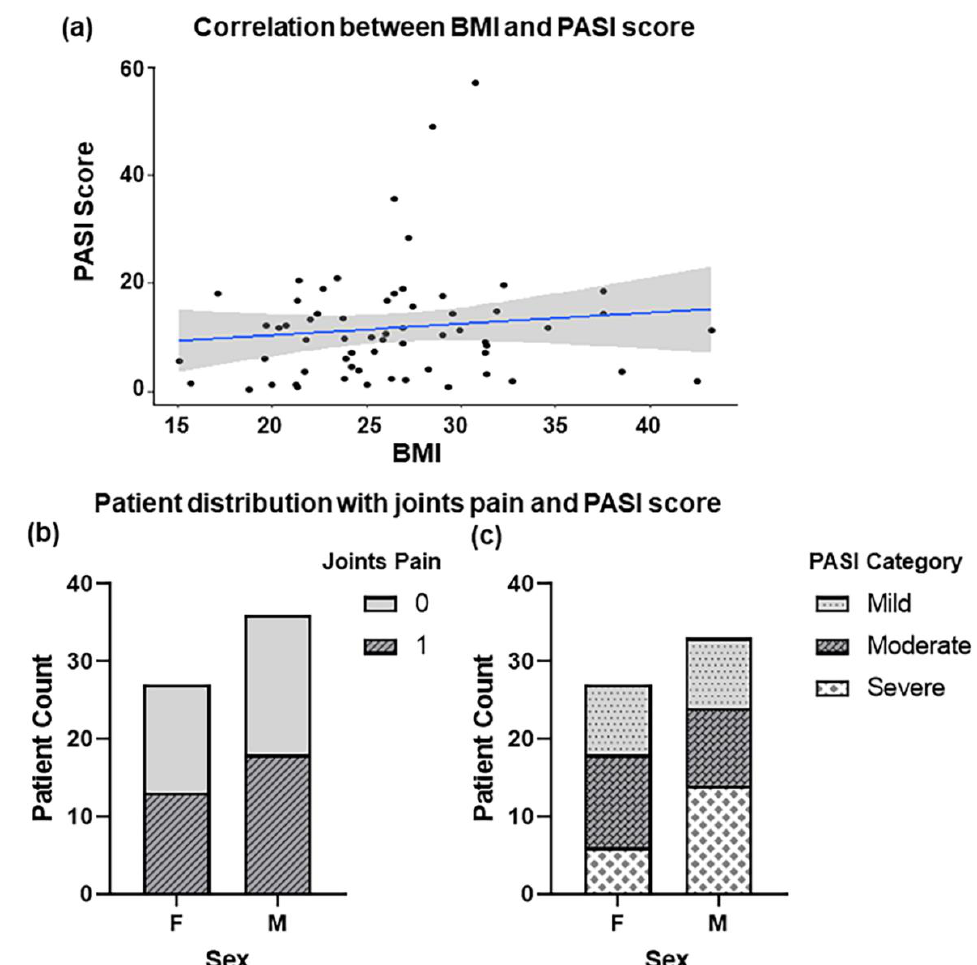
Figure 1. Clinical presentation of psoriasis patients. ( a ) A positive correlation of 0.37 between BMI and PASI score of the patients was observed. ( b ) The proportion of male and female patients that reported joint pain, ( c ) Bar chart showing the severity of psoriasis (PASI scores) in both